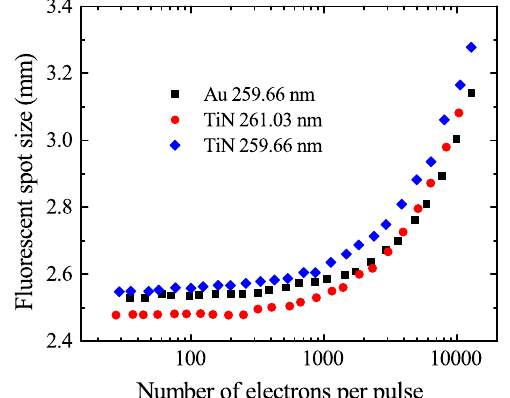
FIG. 7. Root-mean-square fluorescent spot size for Au (at laser wavelength of 259.66 nm) and TiN (at laser wavelengths of 261.03 and 259.66 nm) as a function of the average number of electrons per pulse. The quantum efficiency of gold is 2 . 44 × 10 − 5 , which is about 5 times that of TiN. To emit the same number of electrons as gold, we need to use 5 times the laser intensity to excite